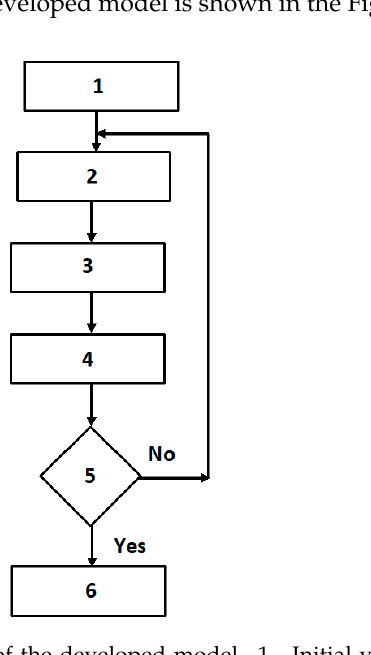
Figure 4. Grid independence tests for local heat transfer along the longitudinal coordinate ( a ) and radial profile of kinetic energy of turbulence at x / H = 5 ( b ). Points (1) are authors’ measured data, curves (2–5) are authors’ simulations results. Re H = 2.09 × 10 4 , 2R 1 = 15 mm, H = 13.5 mm, 2R 2 = 42 mm, ER = (R 2 / R 1 ) 2 = 7.84, x / H = 5, q W = const = 8.95 kW / m 2 , T 1 = T b1 = 298 K, d = 1.7 mm. 2—128 × 50, 3—256 × 100, 4—450 × 200, 5—550 × 200 CVs.